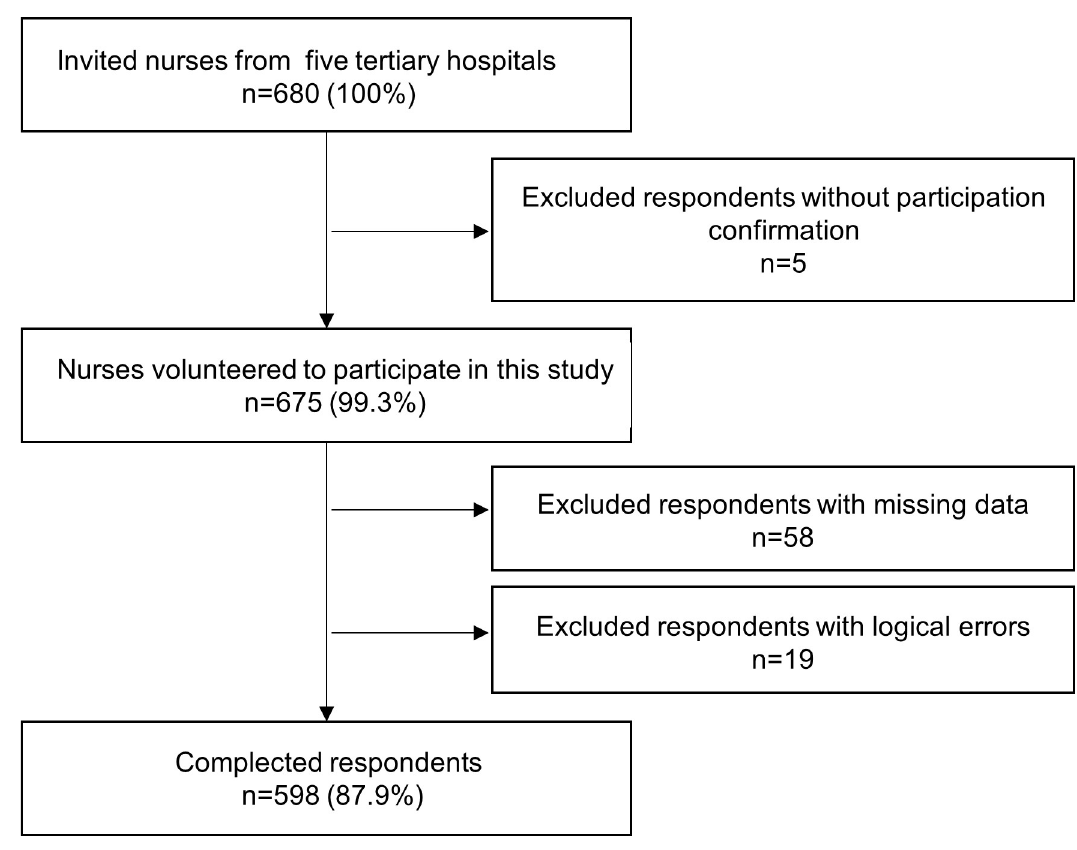
Fig 1. Recruitment